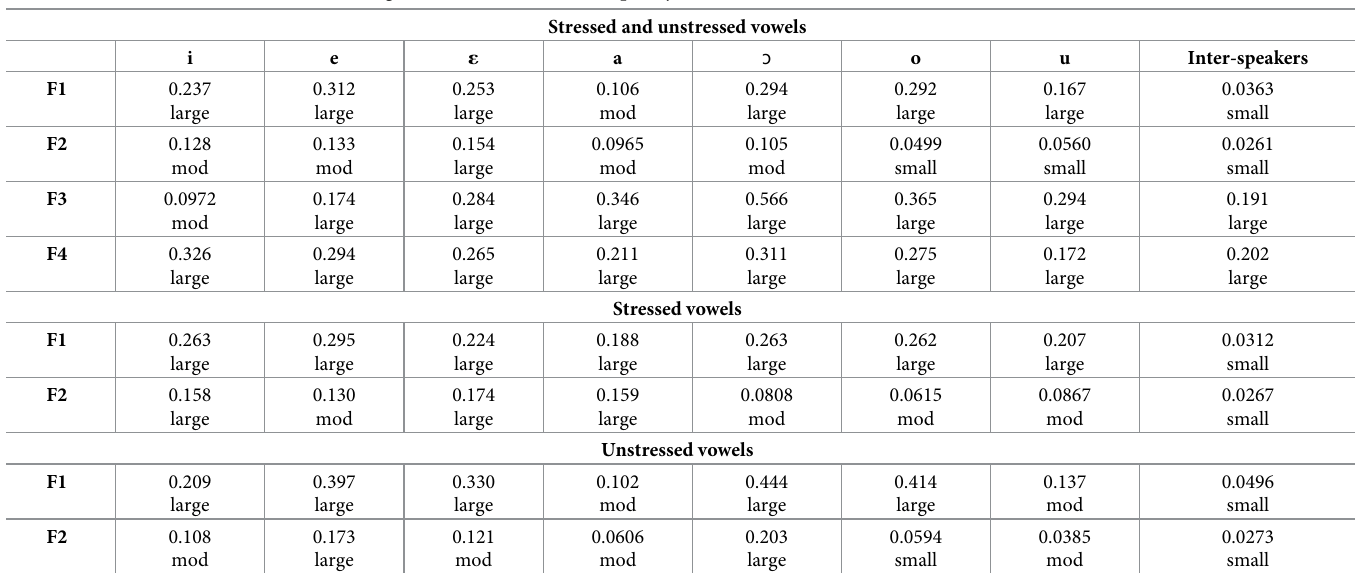
Table 5. Effect size estimates for each vowel segment and each formant